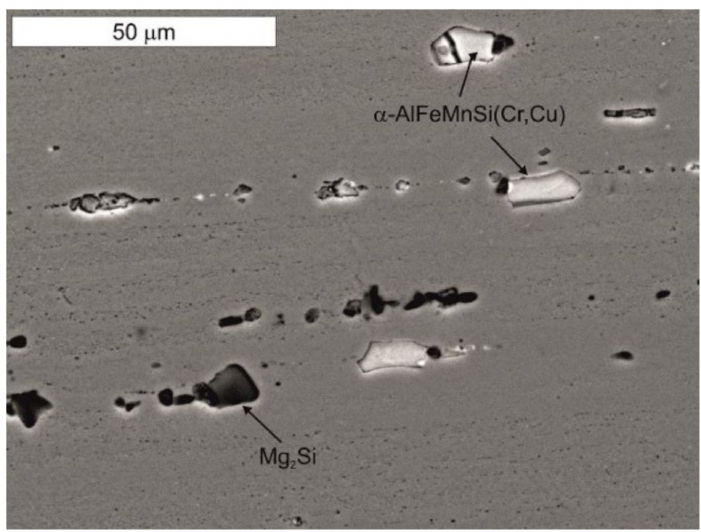
Figure 3. Microstructure of the investigated alloy in the scanning electron microscope image. Visible precipitations of primary phases in the α (Al) solid solution.